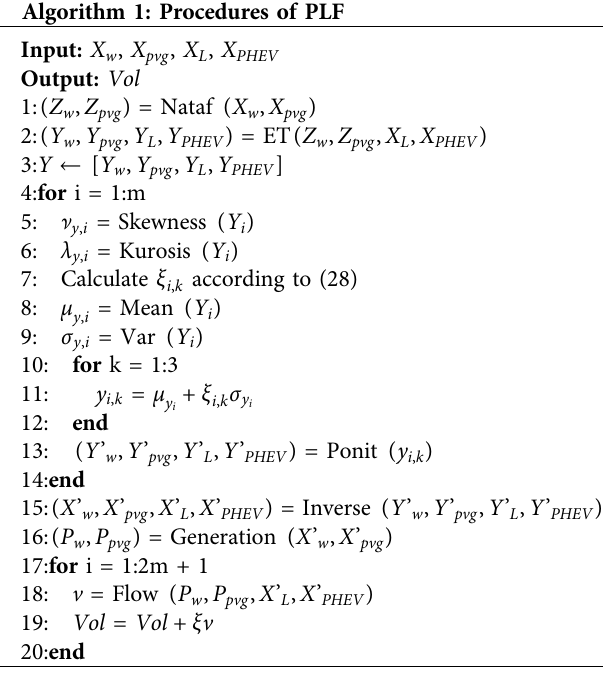
Algorithm 1: Procedures of